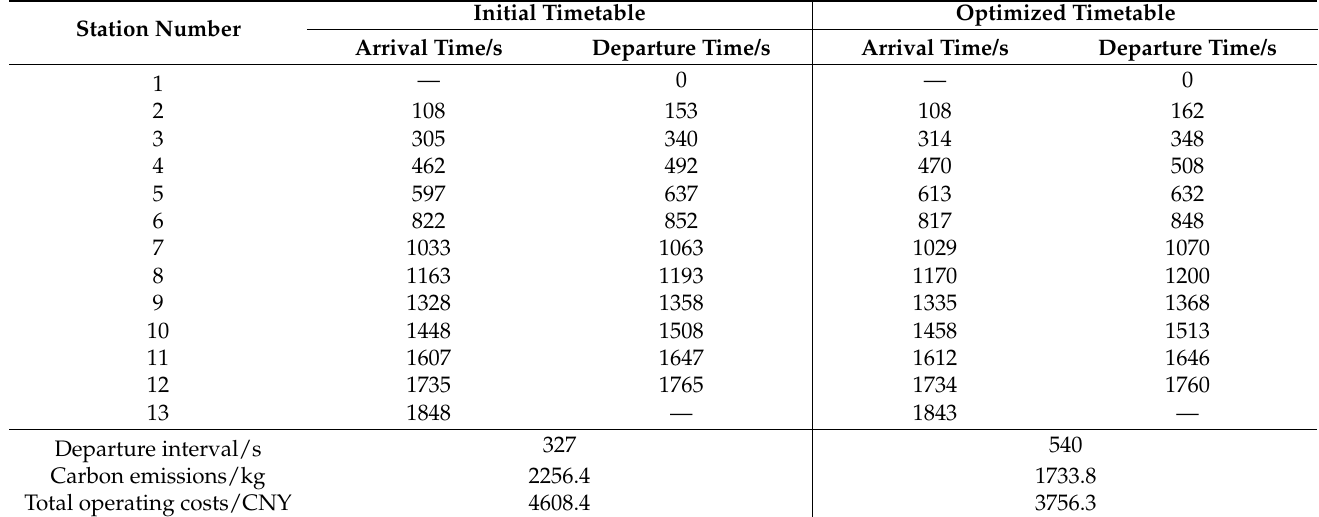
Table 3. Comparison before and after